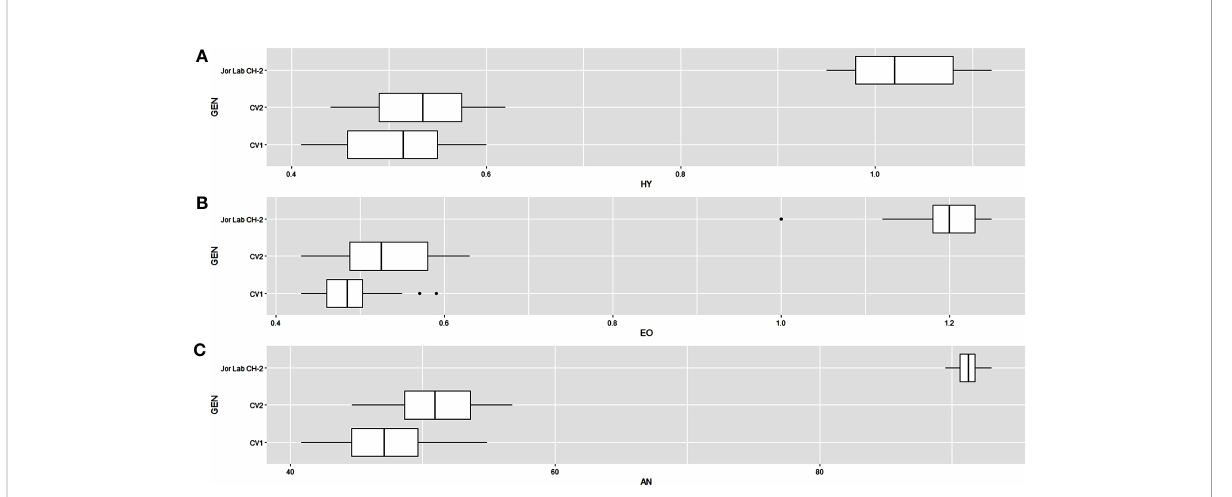
FIGURE 2 AMMI 1 and 2 model biplot for herbage yield/plant (Kg) of Jor Lab CH-2 compared with the check genotypes (CV1 and CV2) evaluated in eight